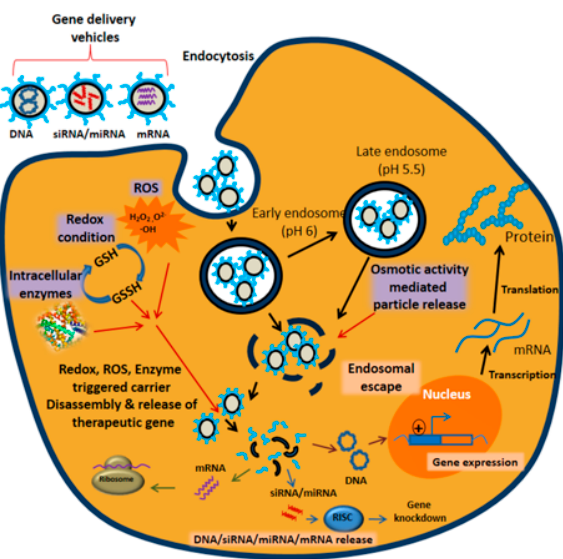
Figure 1. Different intracellular stimuli (ROS, intracellular enzymes, redox condition and osmotic activity) mediated release of gene carriers and subsequent gene release inside cellular environment.